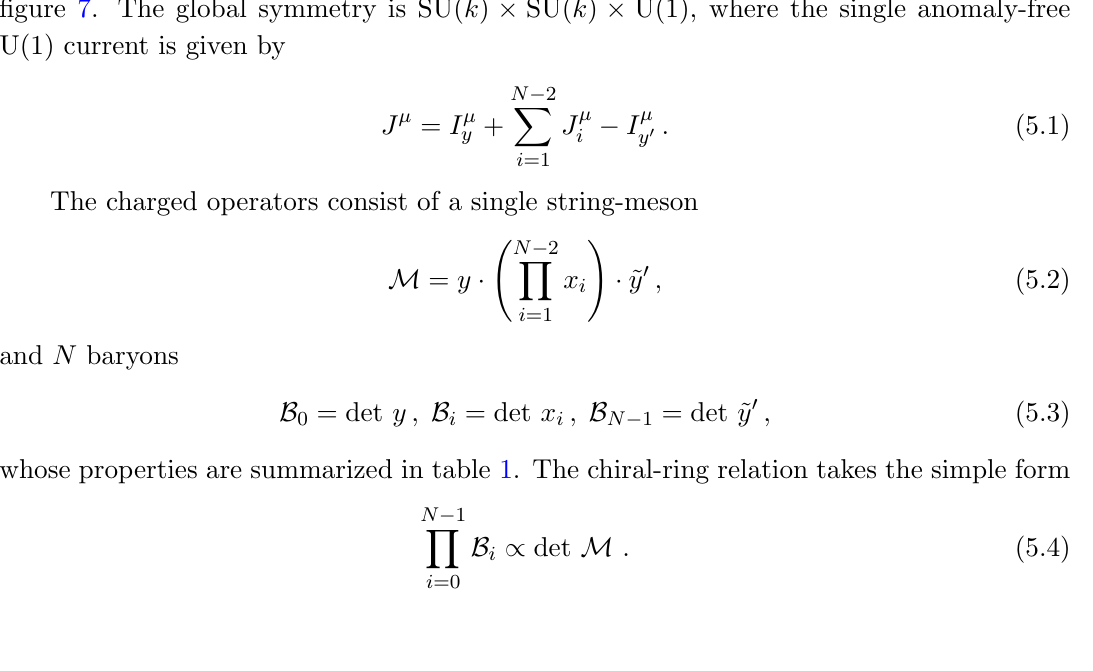
in agreement with the dimension of the baryon operators, and con(cid:12)rming again that the baryon permutation symmetry is gauged in the (cid:12)eld